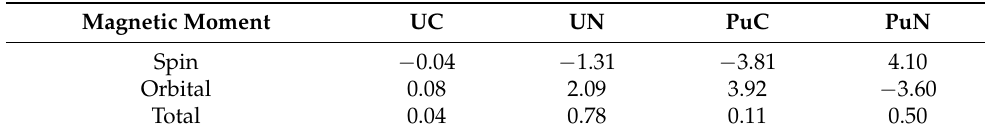
Table 2. The calculated (low temperature) magnetic moments in units of µ B . The only available experimental value is that of UN, 0.75 µ B